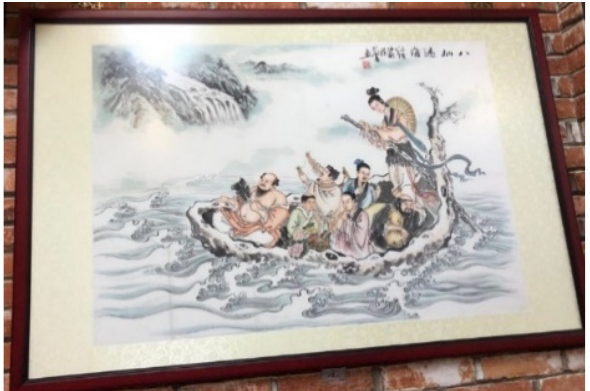
Figure 7. A Painting of the Eight Immortals Crossing the Sea.